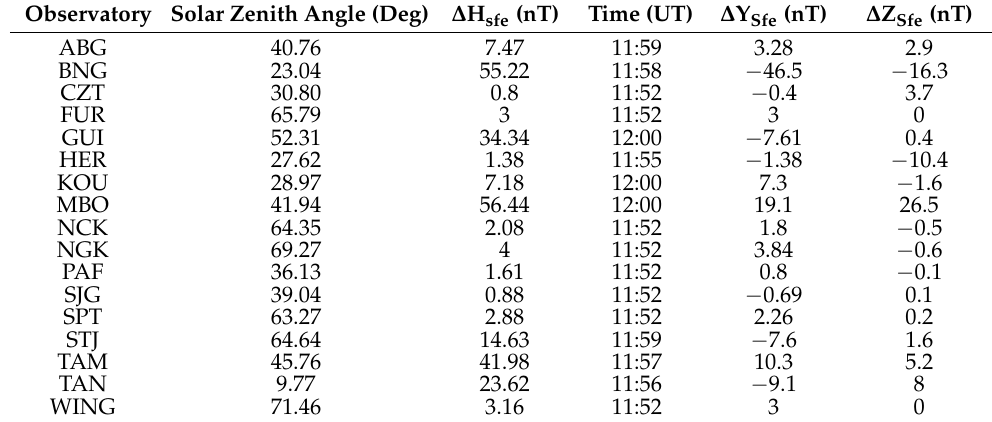
Table 4. The magnetic response to the solar flare X9.4 of 06/11/1997.